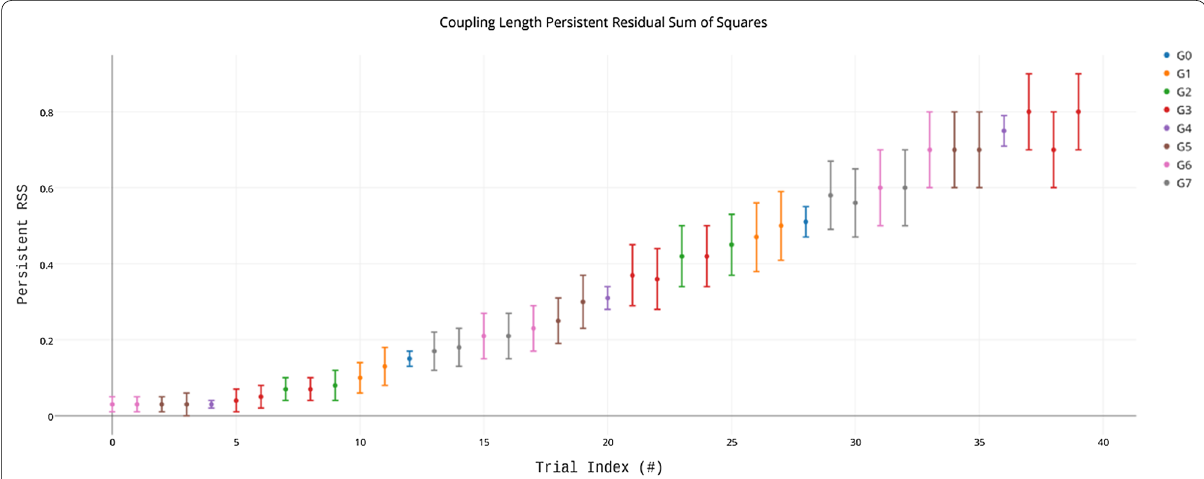
Fig. 19 PRSS values for the 40 trials of CL computations along